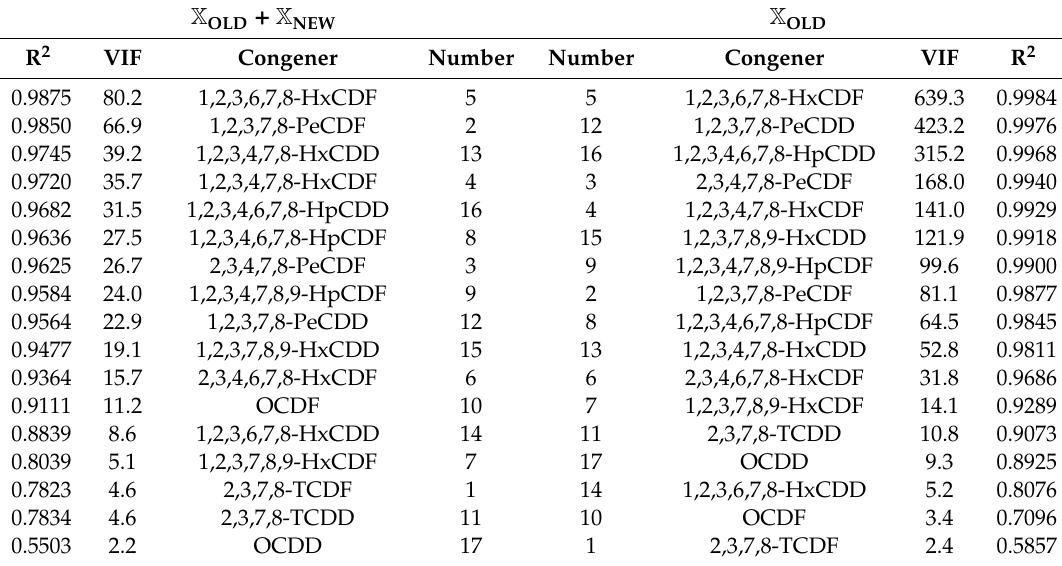
Table 1. Results for VIFs of each congener calculated sequentially, discarding the most linearly dependent congener after each iteration. The left half shows the results for both datasets mixed together ( X OLD + X NEW ) and the right half shows the results from X OLD as a comparison [29]. X + X OLD NEW